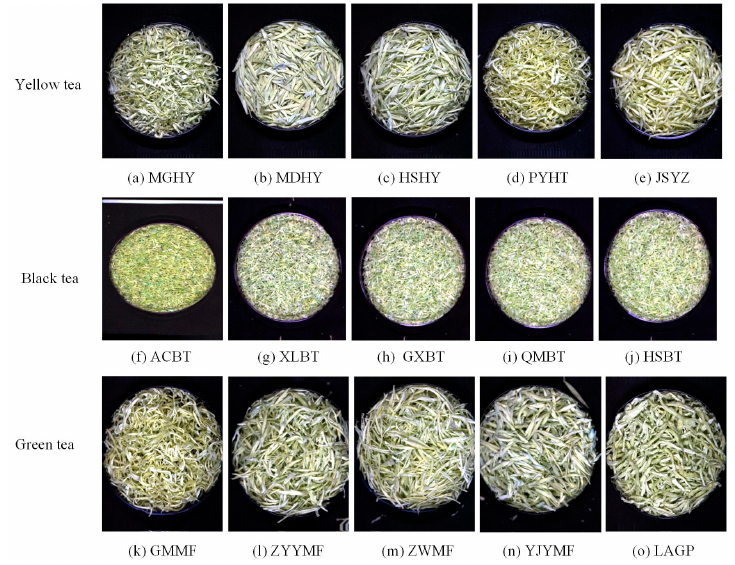
Figure 4. Hyperspectral images of three tea categories including black tea, green tea, and yellow tea.